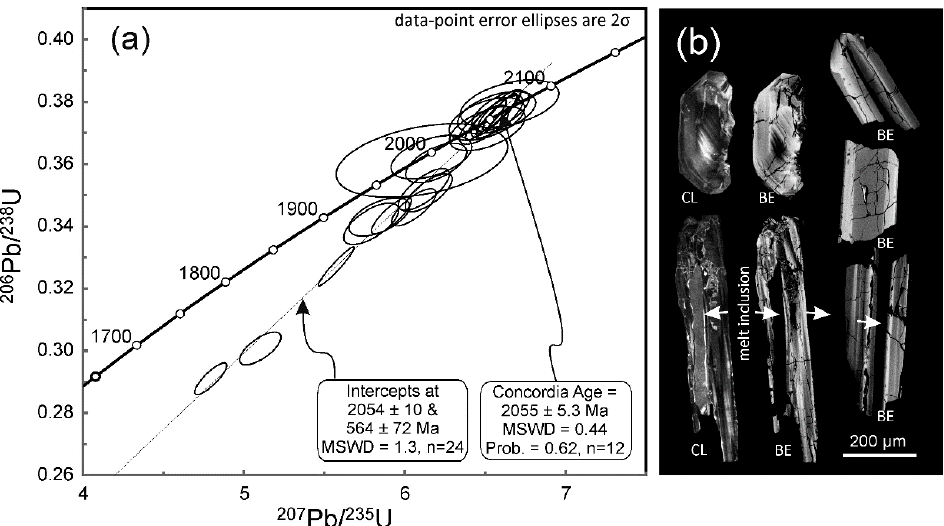
Figure 14. Results of zircon U–Pb dating presented in Concordia diagram ( a ), and of zircon imaging ( b ). Dated zircon grains commonly are fragments of elongated crystals showing oscillatory or banded zoning. Some crystals contain elongated melt inclusions, and many grains are heavily frac- tured. CL—cathodoluminescence; BSE—back scattered electron images.